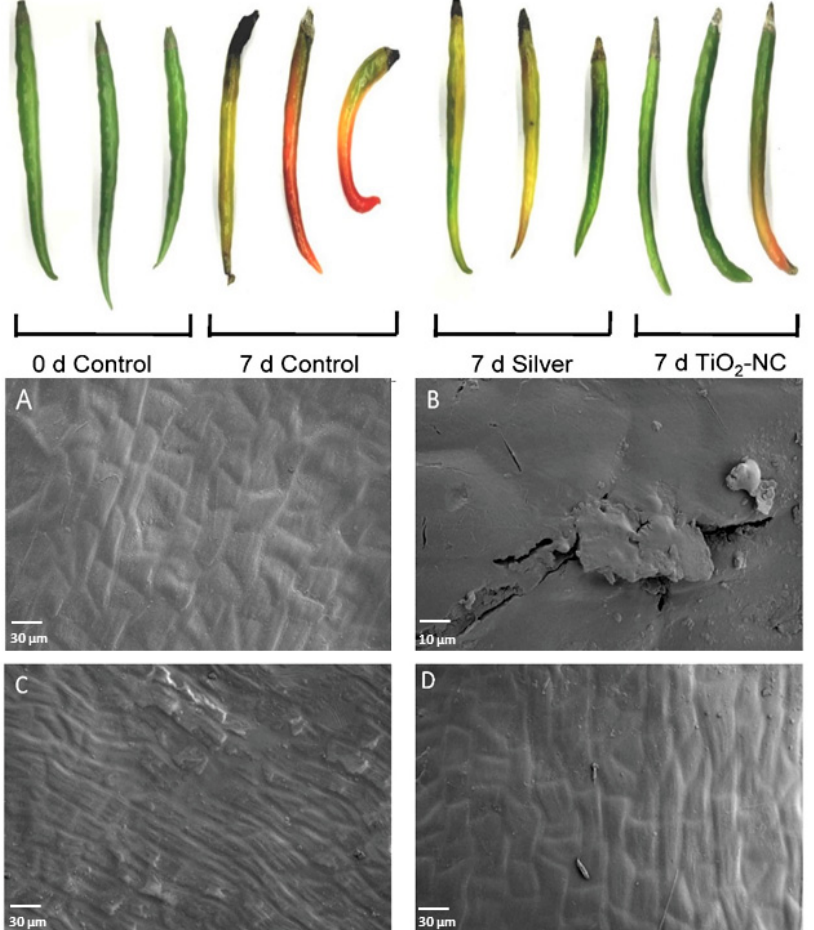
Figure 1. Changes in morphology and changes in fruit coat surface as revealed through scanning electron micrograph (SEM) in Capsicum fruit. The SEM images revealed the microscopic cracks and crevices on fruit coat surfaces and their variations on 7 d ( B ) postharvest storage over 0 d control ( A ). The 7d silver ( C ) and 7d TiO 2 -NC treatments ( D ) had their respective impacts on the possible repair of cell wall lysis.